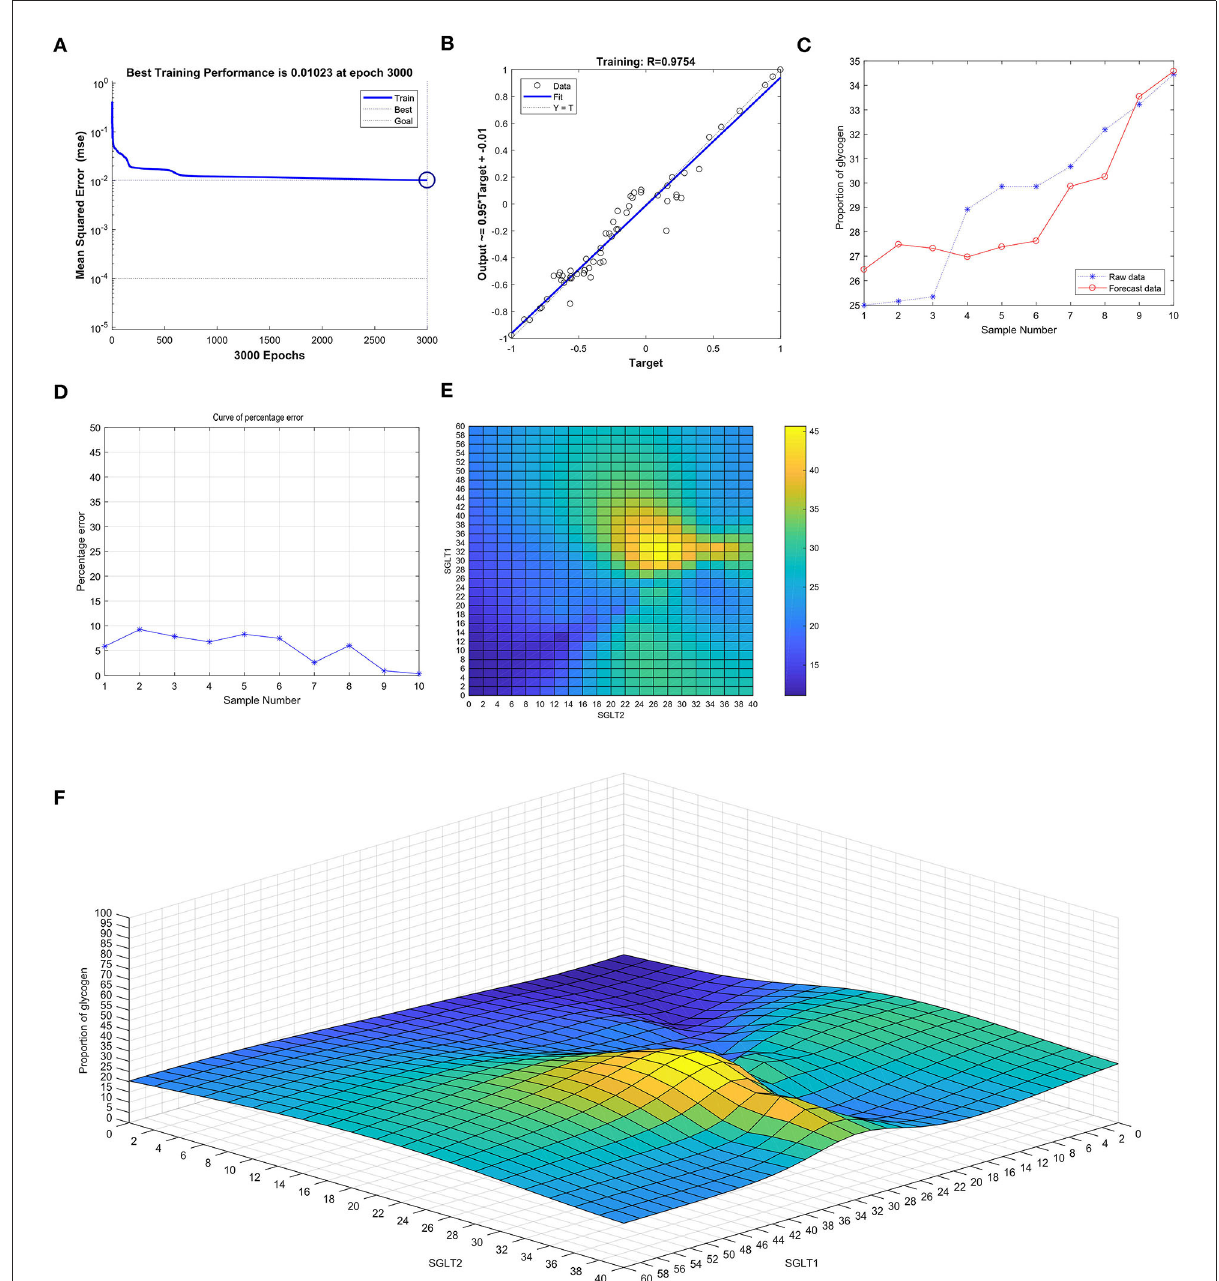
FIGURE11 Neural network prediction model and high-risk warning range of the glycogen content in the kidney based on the expression of SGLT1 and SGLT2. (A) Best training performance was 0.01023 at epoch 3,000. (B) Relativity was 0.9754. (C,D) Through verifying the forecast data against the raw value, we found that there were only small differences. (E,F) High-risk warning indicator of glycogen content in the kidney: 28 < SGLT1 < 42 and 20 < SGLT2 <